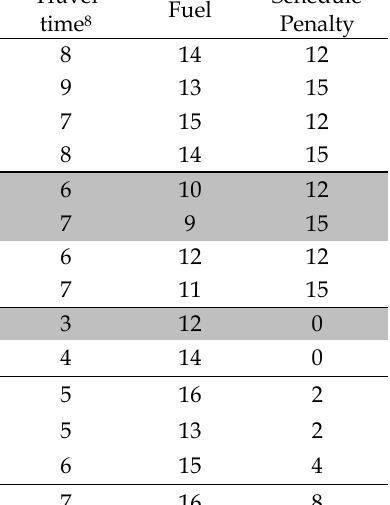
Travel Schedule Fuel time 8